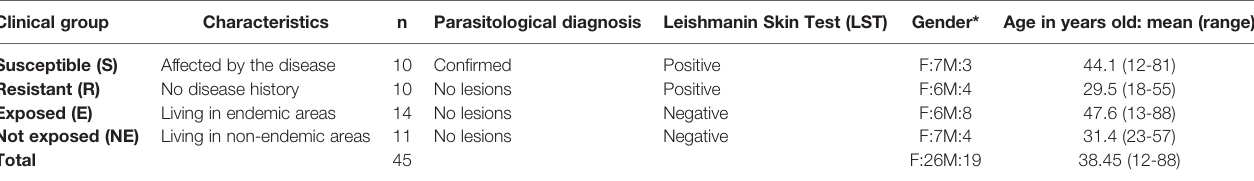
TABLE 2 | Classi fi cation of human volunteers. Clinical group Characteristics